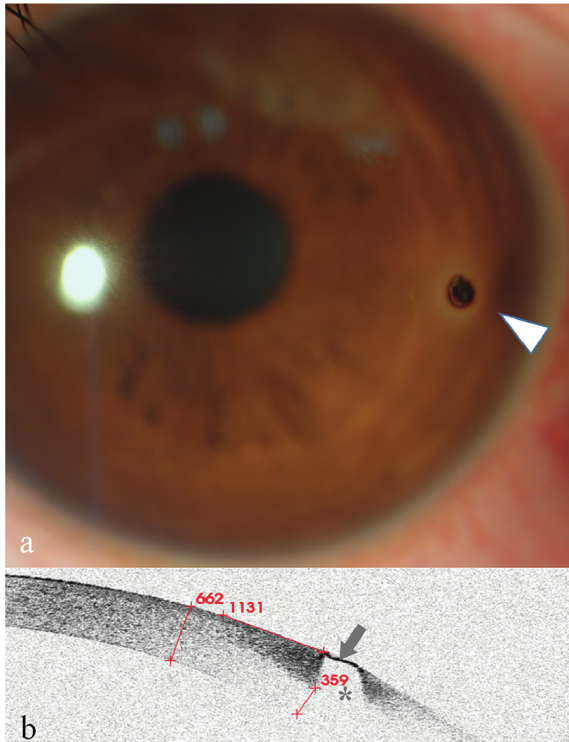
Figure 1: Anterior segment and AS-OCT image for Case 1. (a) Anterior segment photograph showed a corneal FB and inflammatory infiltration around the FB at an approximately 3:00 o’clock location approaching the limbus (arrowhead). (b) AS-OCT image showed that the FB showed a single high signal with clear boundary (arrow) following a central zone shadowing effect (star). The depth of the FB was estimated indirectly by subtracting the thickness of the underside of the high-reflected signal surrounding a FB (359 m) from the thickness of the cornea (662m), which was less than 303 μ